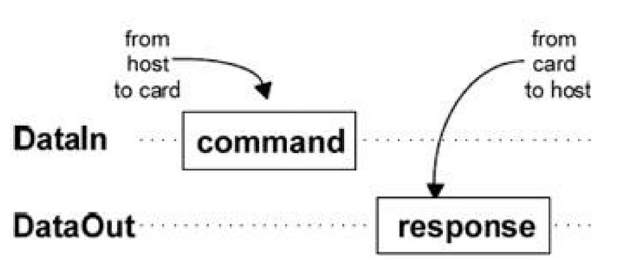
Figure 4. SD card command transfer